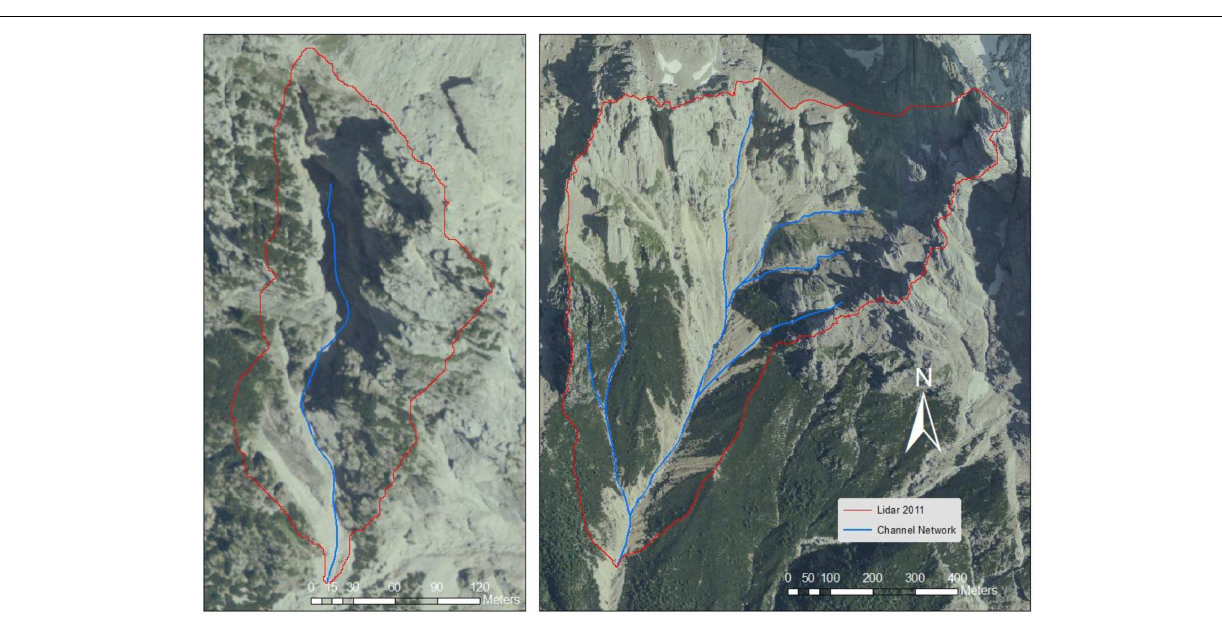
FIGURE 3 | Channel network (blue line) of the two basins of Dimai (left) and Rovina di Cancia (right) obtained through LiDAR2011 DEMs.